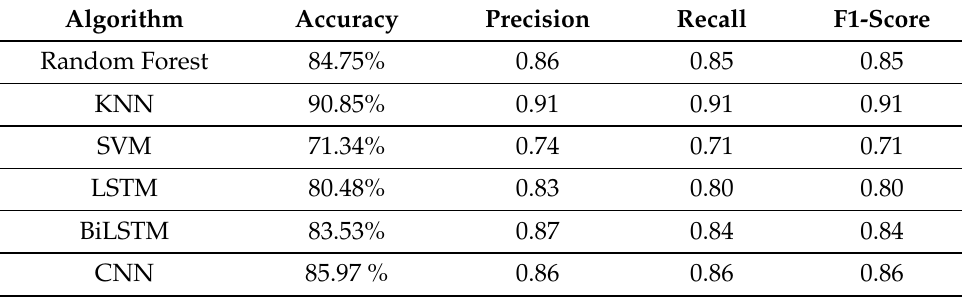
Figure 6. Machine learning results using raw image data. Table 2. Machine learning results using raw image